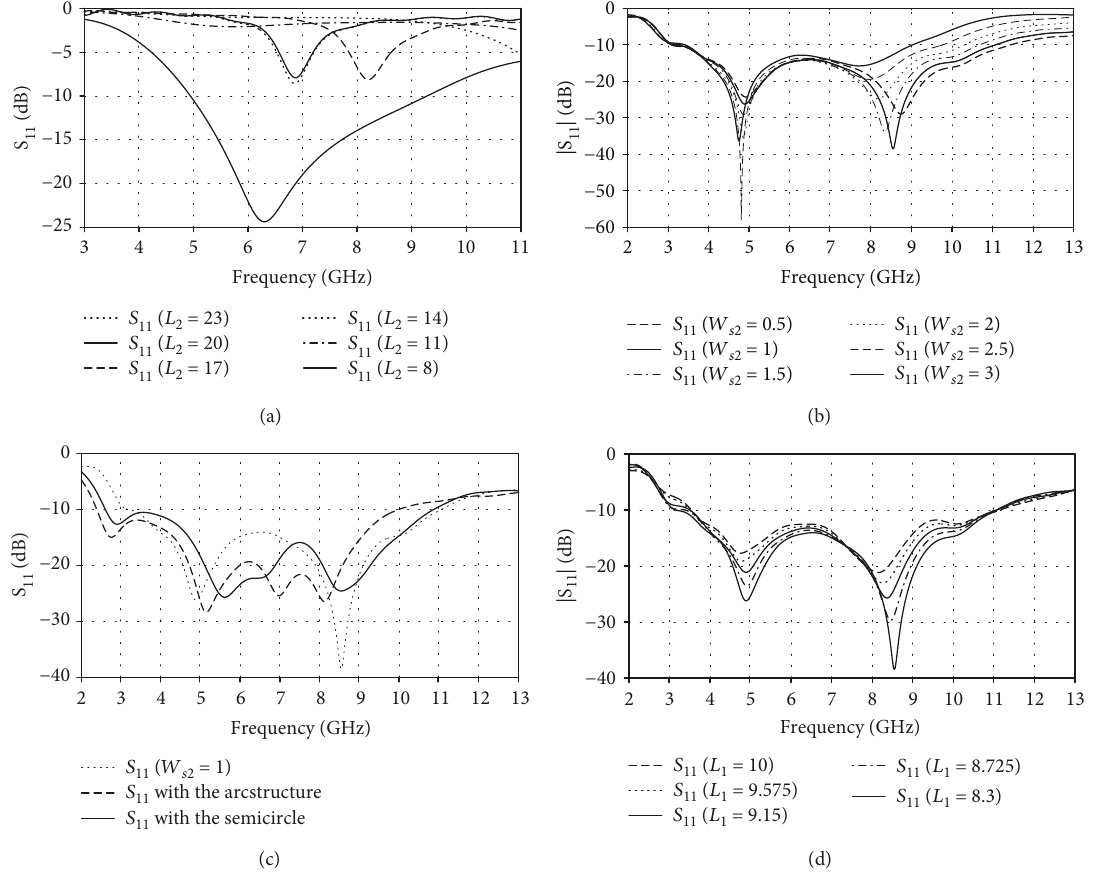
Figure 3: (a) | S 11 | of antenna 1. (b) | S 11 | of antenna 2. (c) | S 11 | of antenna 3. (d) | S 11 | with varying L 2